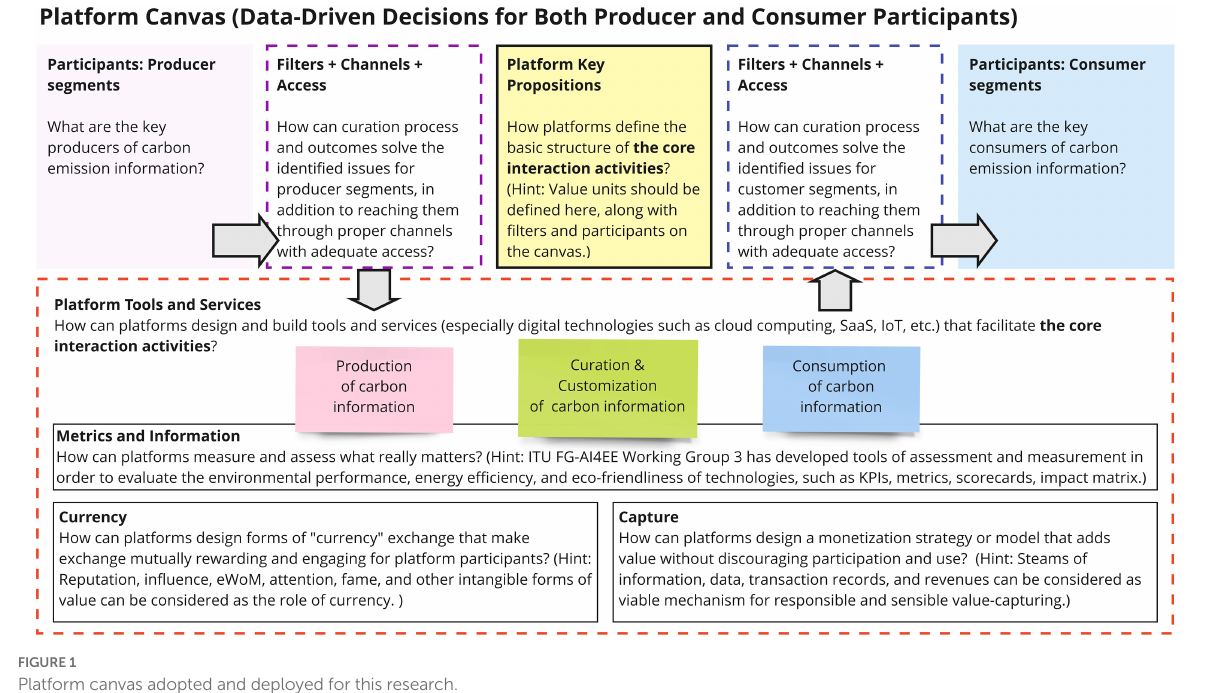
FIGURE 1 Platform canvas adopted and deployed for this